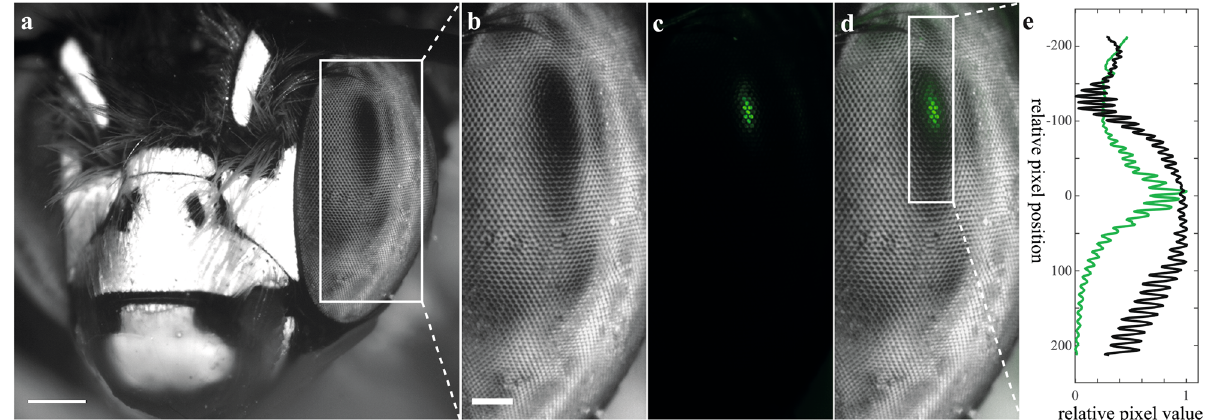
Figure 3. Induced fluorescent and dark pseudopupil overlap. (a) Head of the bee Anthophora sp. These bees have clear eyes and its dark pseudopupil is evident as a black spot on the eye surface. Image acquired with a Nikon SMZ18 equipped with a bright field filter cube (P2-EFLBF) and a ¼ wave plate. The eye was stained with Neurobiotin 488 (see “Methods”). Scale bar: 500 µm. (b) Zoomed-in view of the area marked by the white rectangle in (a) showing more clearly the dark pseudopupil in the left eye. It is common to see multiple pseudopupils resulting from the incident light from the environment around the eye. (c) Zoomed-in view of the area marked by the white rectangle in (a) , after using a P2-EFLGFP-B filter cube—the induced fluorescent pseudopupil was visible in the same sample (in vivo). (d) Co-visualization of the dark (b) and induced fluorescent pseudopupil (c) showing a clear overlap of the two. (b–d) Scale bar: 200 µm. (e) Relative pixel values for the induced fluorescent and dark pseudopupils in the area marked in (d) by a white rectangle . Note that the centres of the two (i.e. max relative pixel value) coincide, with the induced fluorescent pseudopupil having the centre much more easily identifiable compared to the dark